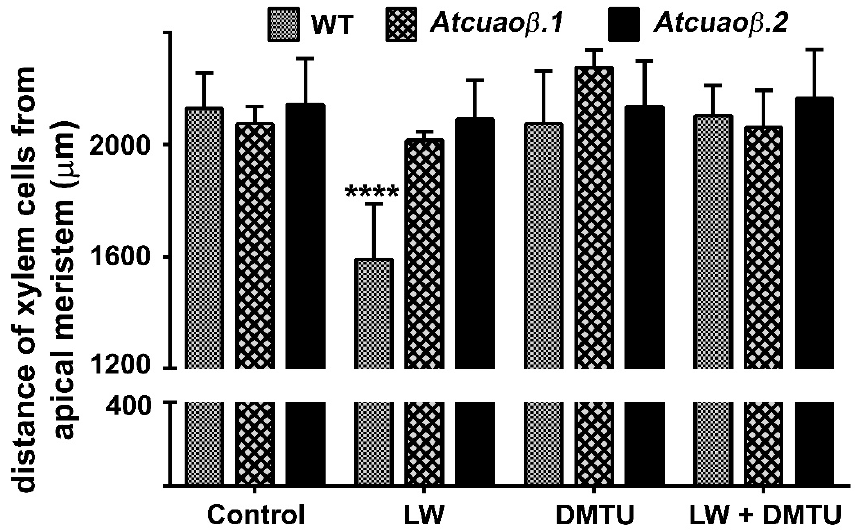
Figure 2. Analysis of di ff erences in protoxylem maturation in 10-day-old leaf-wounded (LW) WT and mutant ( Atcuao β .1 and Atcuao β .2 ) seedlings, grown in medium with or without the H 2 O 2 -scavenger DMTU at a final concentration of 100 µ M. Distances from the apical meristem of the protoxylem position (defined by the position of the first protoxylem cell with fully developed secondary cell wall thickenings) are reported. These experiments were repeated at least three times with 10 seedlings analyzed each time (mean values ± SD; n = 30). The statistical significance levels ( p -values) were evaluated with one-way analysis of variance (ANOVA) followed by Sidak’s multiple comparison test (****, p ≤ 0.0001). Insignificant di ff erences are not indicated.